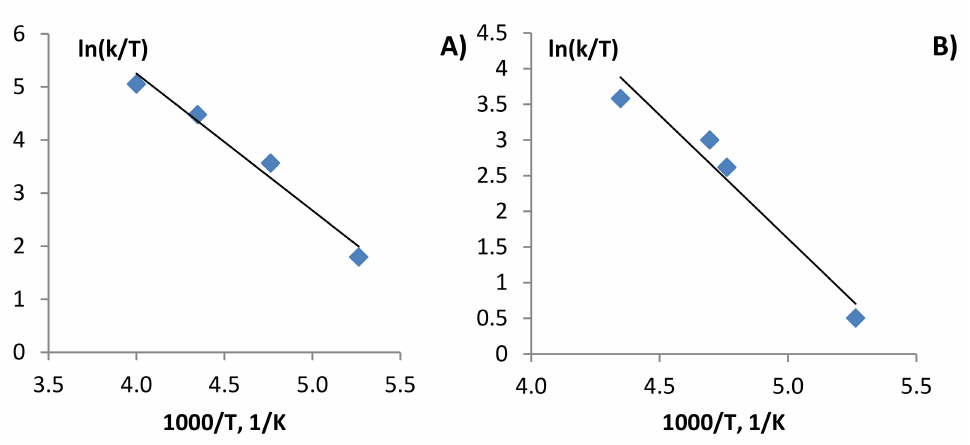
Figure 3. Dependence of ln( k / T ) on 1/ T , where k is the rate constant of the intramolecular dynamic process in « A » ( A ) and « B » ( B ) forms of complex ( I ), T is the temperature and CDCl 3 /CD 2 Cl 2 is the solvent. The determination of the rate constants of the processes and the free energy of ac- tivation was similar to the procedure described in the works [21,25] (related analytical expressions are also presented in [17]; Figure 3). The Gibbs free energy for the activation ∆ G (cid:54) = (298 K)of intramolecular dynamics in both forms was very close to each other and had the values of 40 ± 3 and 37 ± 3 kJ/mol for « A » and « B » forms, respectively. The molecular dynamics occurring in calixarene complexes are described by dif- ferent processes. One of them, and one that has been relatively wellstudied [26], is the pinched cone - pinched cone interconversion described above. In addition, structural rearrange- ments associated with transitions between cone , partial cone , 1,2- alternate and 1,3- alternate states are possible [26]. At different times and for different compounds, the energy pa-